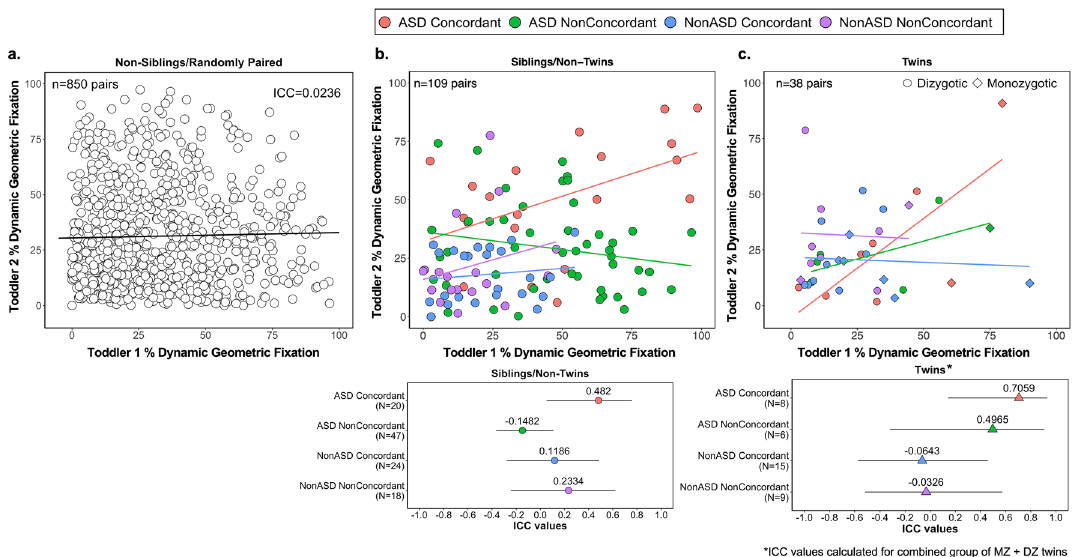
Figure 4. Eye-tracking among siblings and monozygotic and dizygotic twins highlights the genetic basis of the GeoPref Test. Scatterplots comparing percent fixation to dynamic geometric images (DGI) among ( a ) non-sibling/randomly paired toddlers, ( b ) sibling/non-twin toddler pairs, and ( c ) twin toddler pairs. Intraclass correlation coefficients are also shown in ( a ) or plotted, along with the 95% confidence intervals, based on concordance for ASD ( b , c , bottom). ASD Concordant: both siblings/twins received a diagnosis of ASD. ASD NonConcordant: One sibling/twin received an ASD diagnosis while the other received a non-ASD diagnosis. NonASD Concordant: both siblings/twins received the same diagnosis but were non-ASD. NonASD NonConcordant: Each sibling/twin had a different, non-ASD